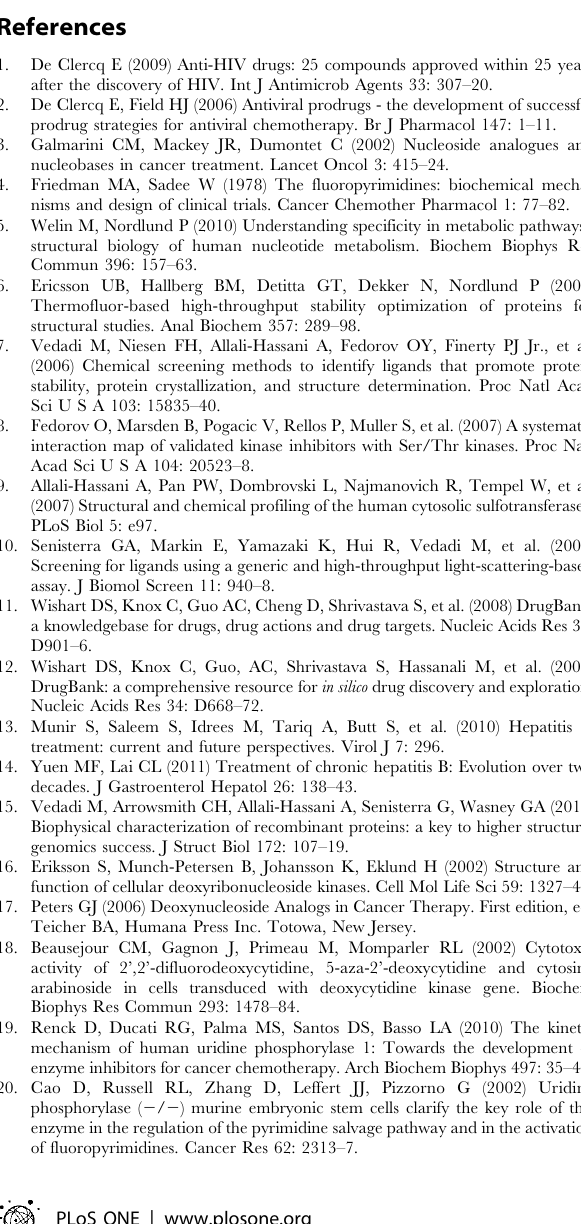
Table S1 Data and refinement statistics for GDA in